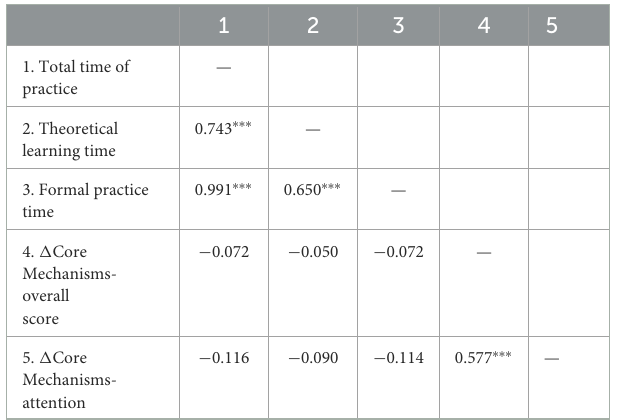
TABLE 7 Partial correlation between exercise time and change in cognitive intervention effect